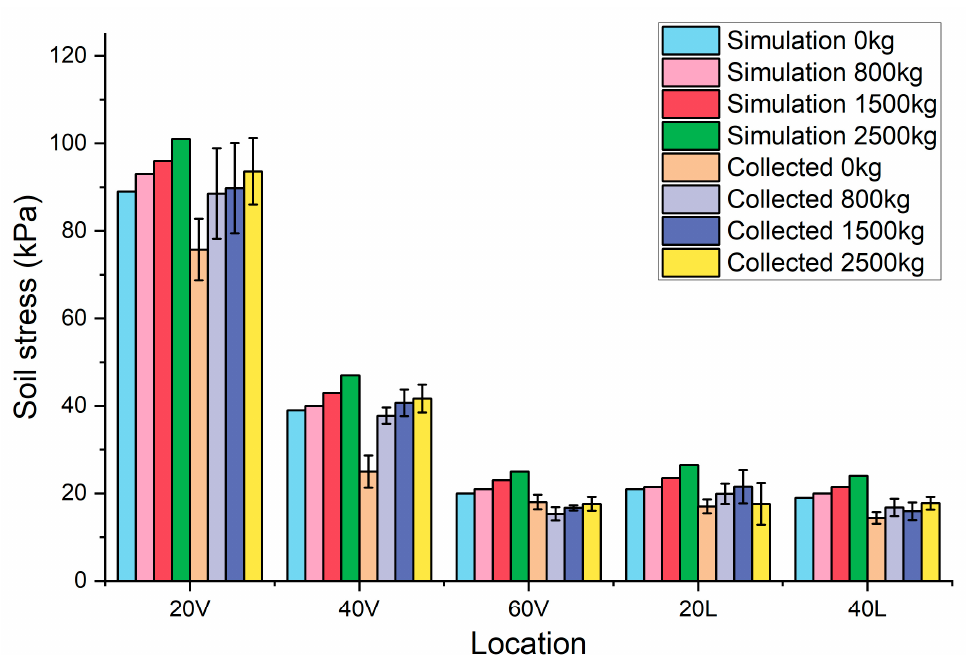
Figure 10. Simulated and collected soil stress comparison.